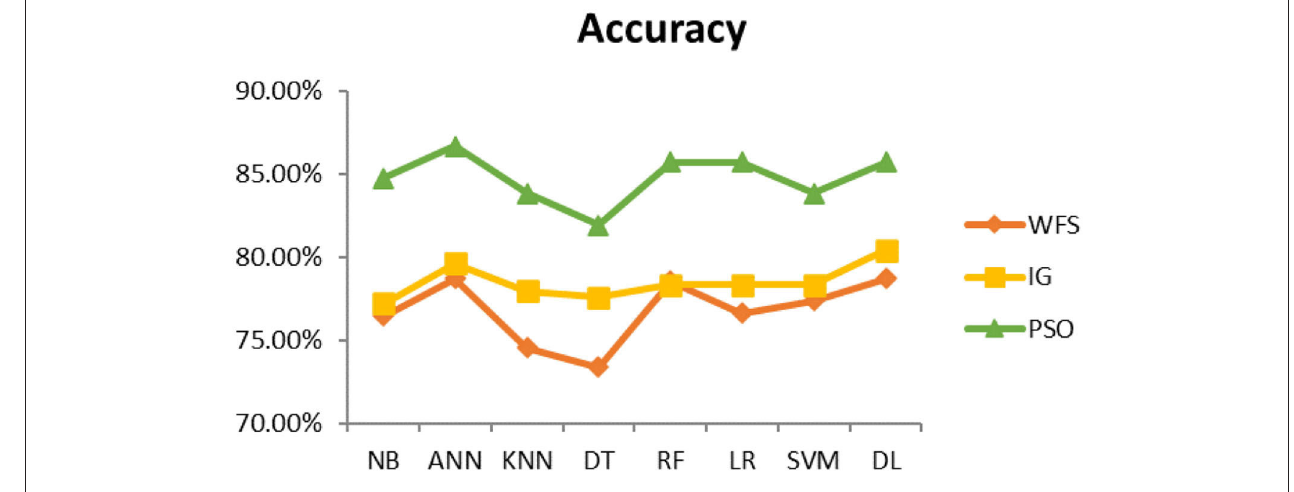
FIGURE 5 | Diabetes diagnosis accuracy (dataset 1).